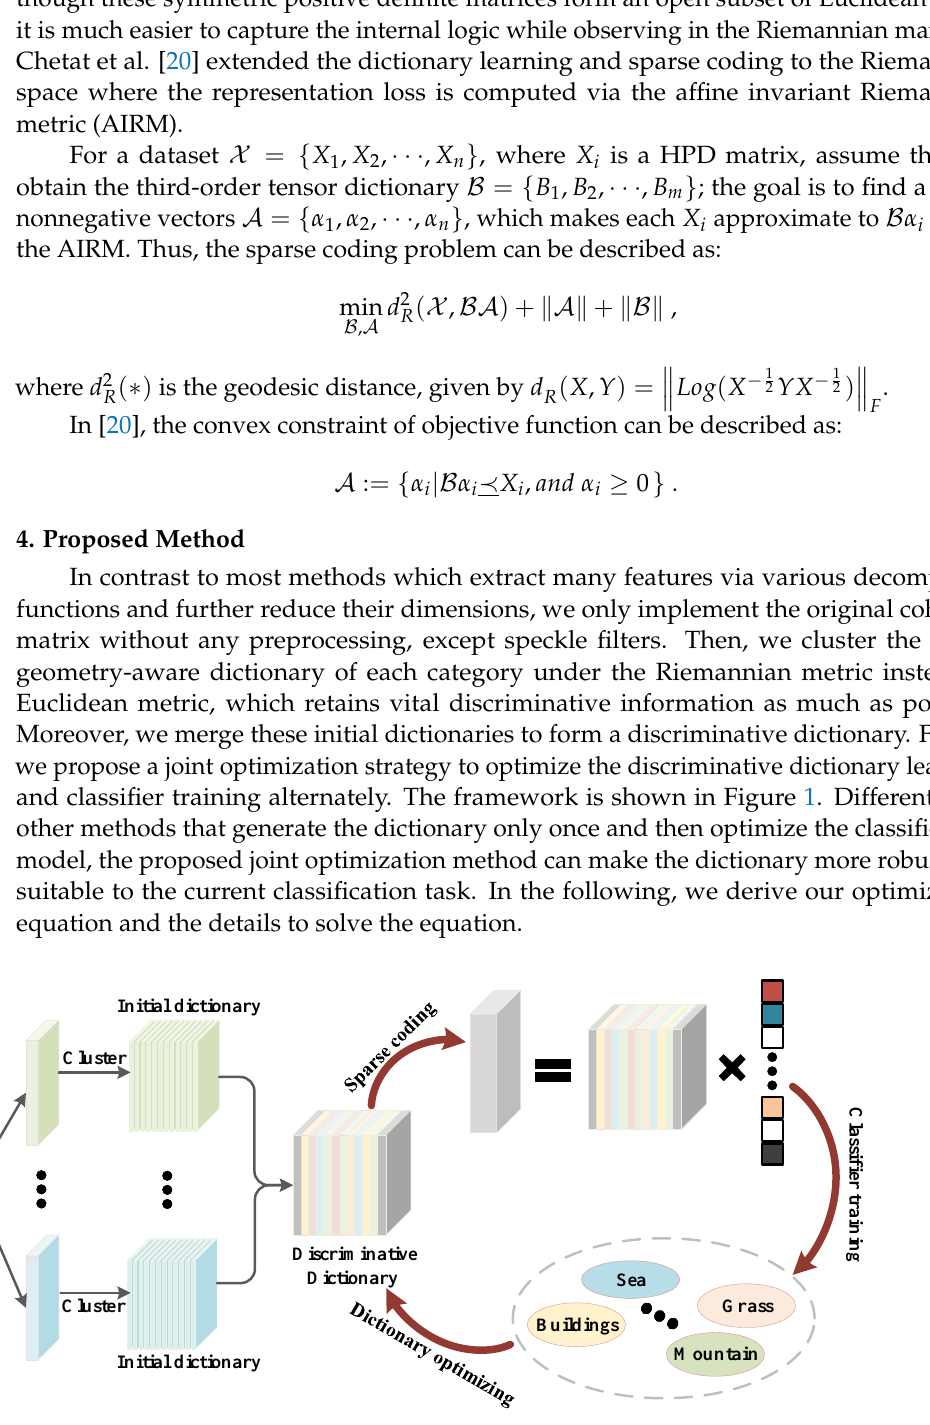
Figure 1. The framework of our method in the training